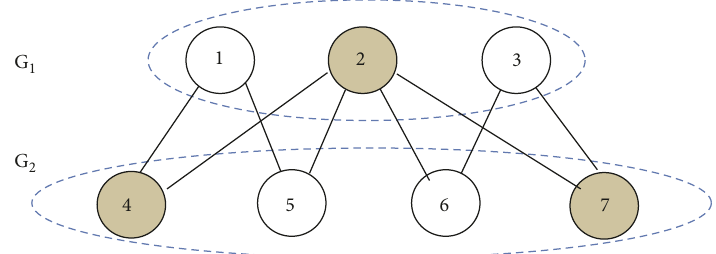
Figure 1: The bipartite digraph topology of the heterogeneous